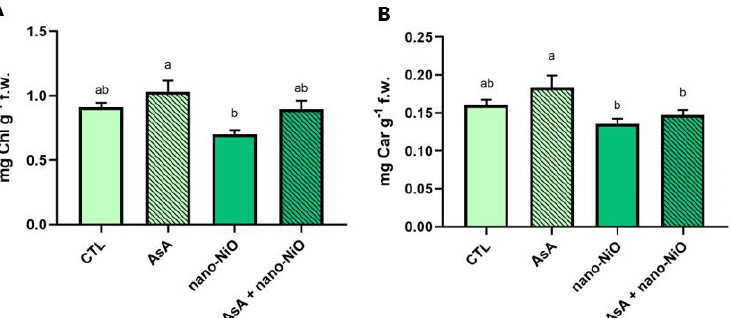
Figure 3. Effects of nickel oxide nanomaterials (nano-NiO; 30 mg L − 1 ) and/or ascorbate (AsA; 150 mg L − 1 ) on the content of chlorophylls (Chl; A ) and carotenoids (Car; B ) in the shoots of in vitro grown tomato plantlets. Data presented are mean ± SEM (n ≥ 3) (f.w.: fresh weight ). Different letters above bars indicate significant statistical differences between treatments at p ≤ 0.05.